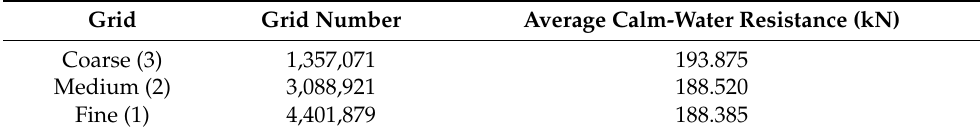
Table 8. Grid information and the resulting average calm-water resistance. Figure 11. Numerical model and convergence study in the calculation of calm-water resistance, where ( a ) is the fluid domain extents and grid partition, ( b ) is the relationship of grid numbers to the average calm–water resistance and ( c ) is the time-step convergence study of the numerical calculations carried out with the Courant numbers, where C = 0.075, 0.1, 0.25, and 0.5, respectively.